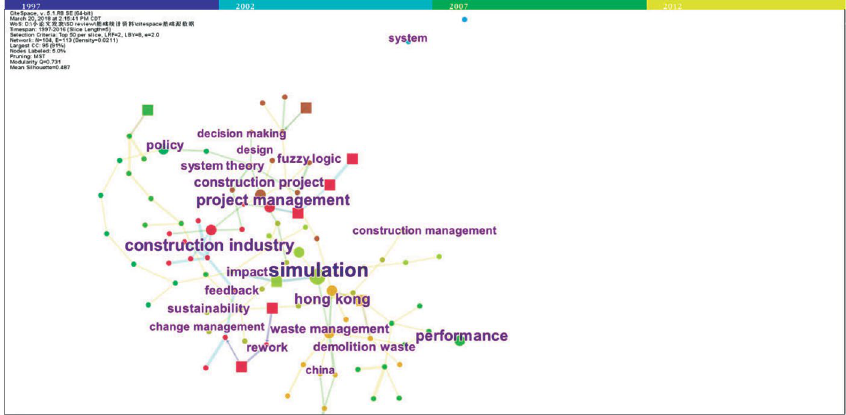
Figure 3. Keyword co-occurrence